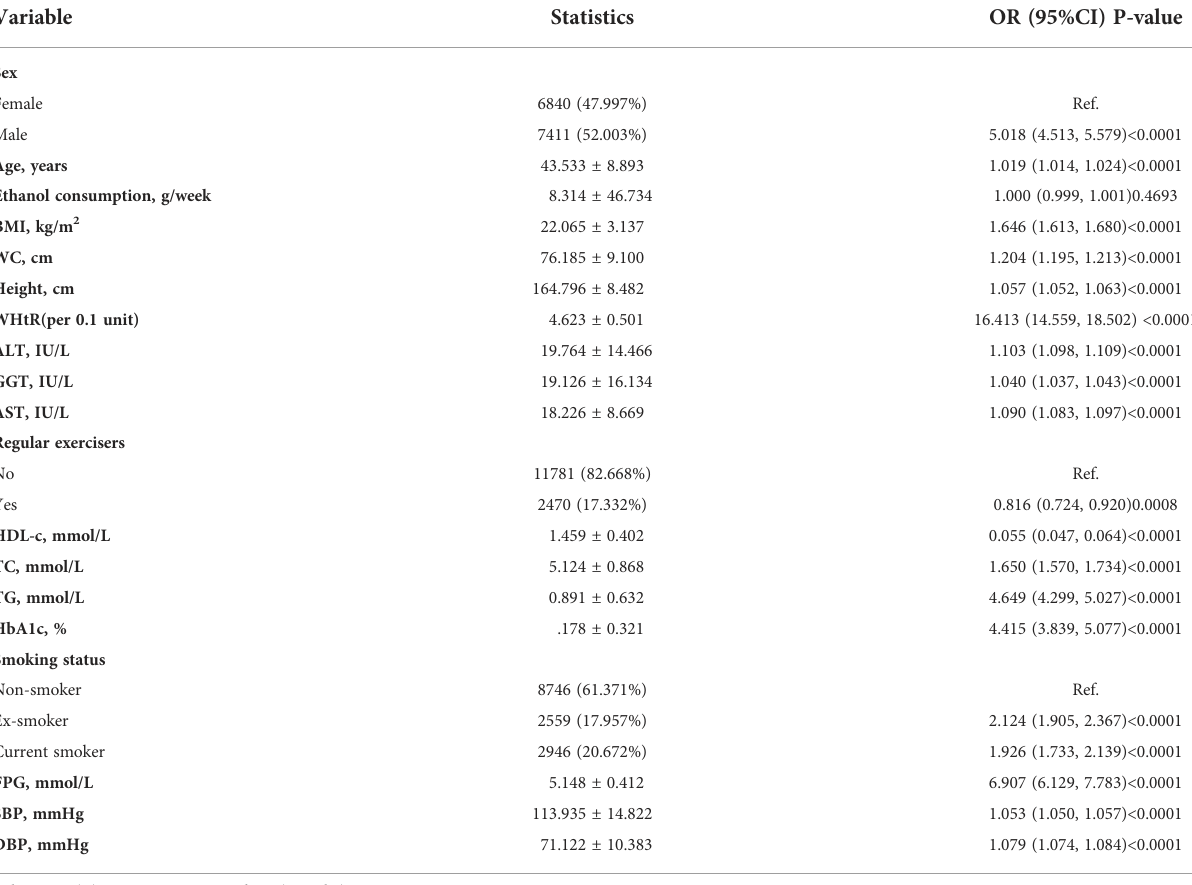
TABLE 3 The results of the univariate